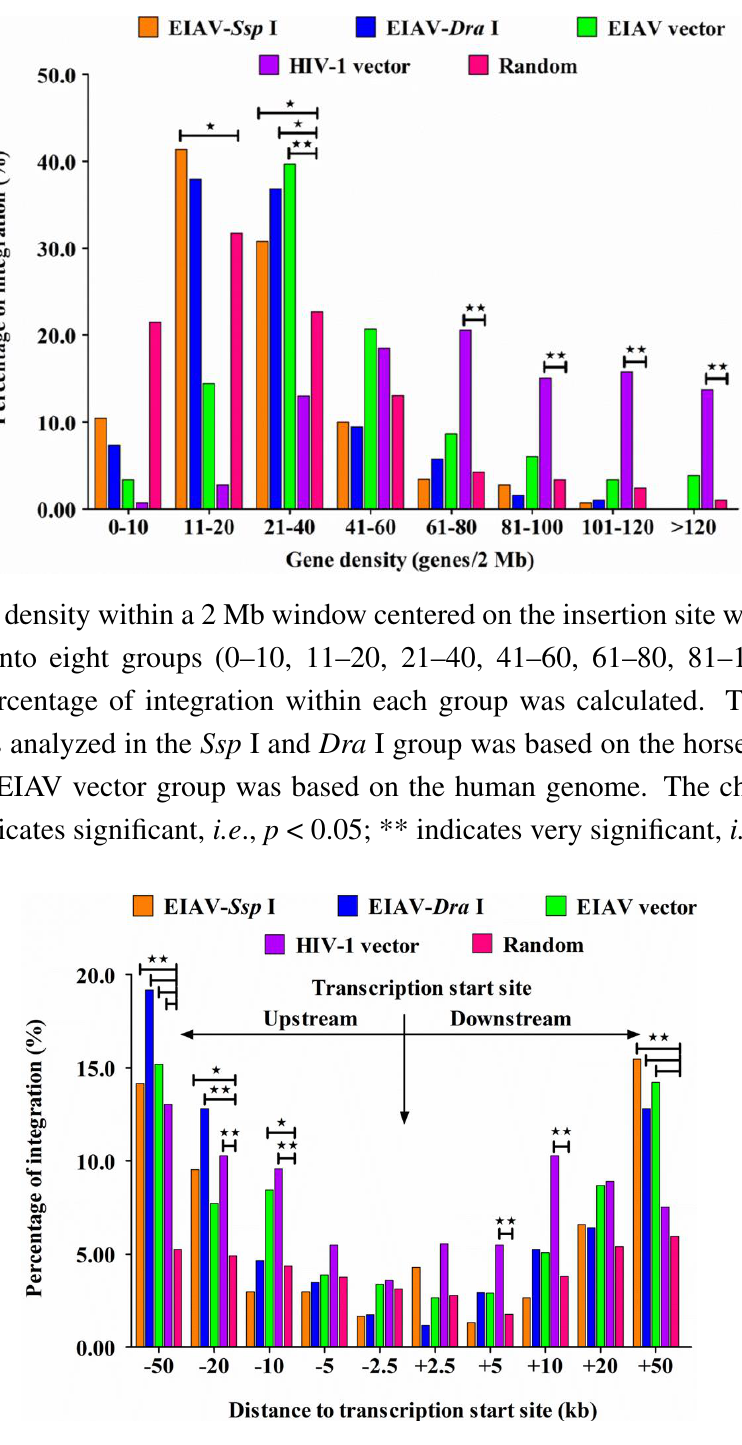
Figure 5. Frequencies of integration at different nucleotide windows up- and downstream of TSS. Five symmetric variable-size windows near the TSS in the host genome were indicated, and their corresponding frequencies were calculated (0–2.5, 2.5–5.0, 5.0–10, 10–20, and 20–50 kb). The number of integration sites analyzed in the Ssp I and Dra I group was based on the horse genome; and the HIV-1 and EIAV vector group was based on the human genome. The chi-squared test was used. * indicates significant, i.e ., p < 0.05; ** indicates very significant, i.e ., p < 0.01.